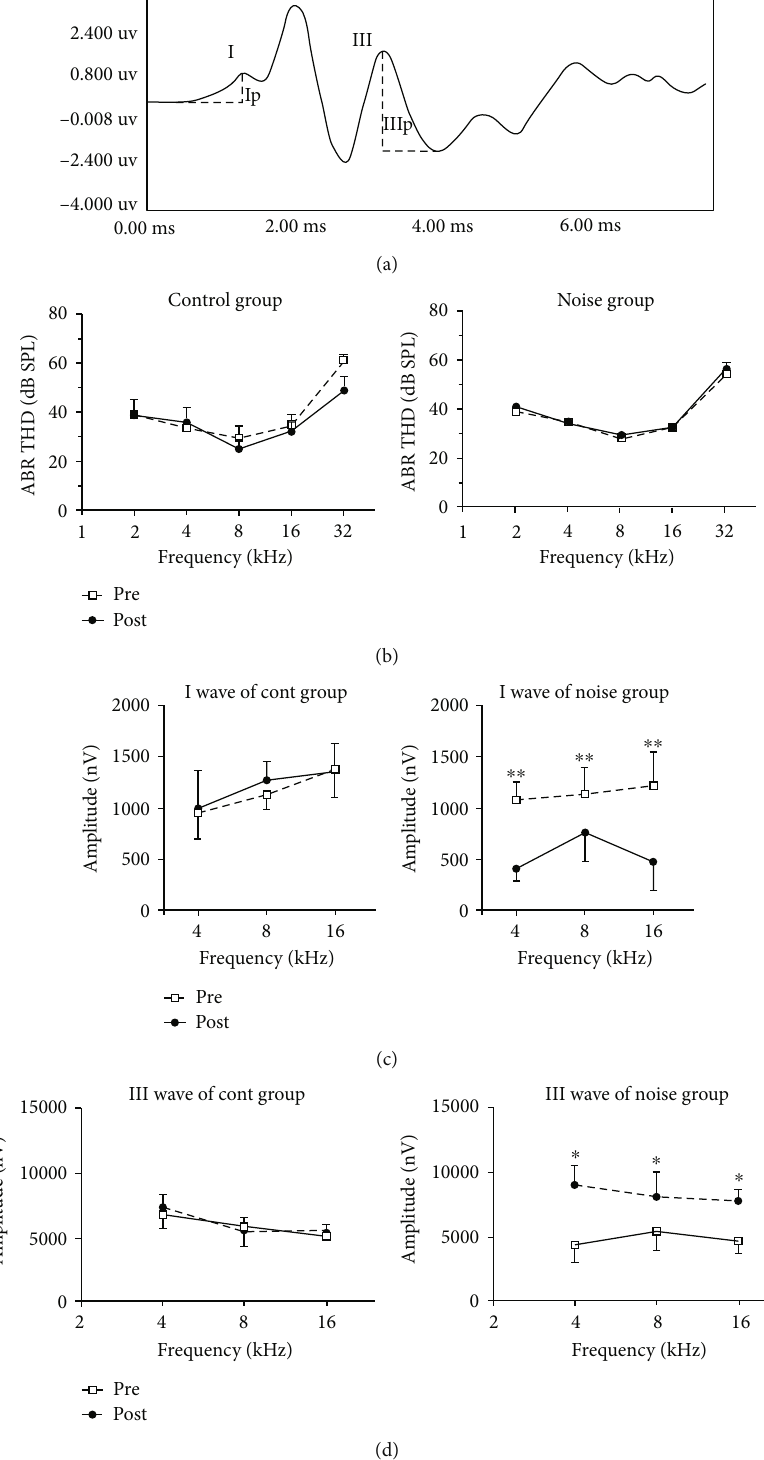
Figure 1: Auditory brainstem response (ABR) was measured in control and noise-exposed mice. The noise groups were exposed to moderate- level background noise (83dB SPL) for 8hrs each day for 2 weeks. (a) A typical ABR response at 90dB SPL, with waves I and III marked. (b) The average ABR threshold in control and noise groups. There was no signi fi cant di ff erence in the ABR thresholds in the noise group compared to controls. (c) The amplitudes of wave I at 90dB SPL of both groups before and after noise exposure. Signi fi cant decrease in the amplitude of wave I was detected in the noise group ( p < 0 : 05 ), especially at 16kHz ( p < 0 : 01 ). (d) The amplitudes of wave III at 90dB SPL of both groups. Signi fi cant increase of wave III amplitude was detected in the noise group at 4, 8, and 16kHz ( p < 0 : 05